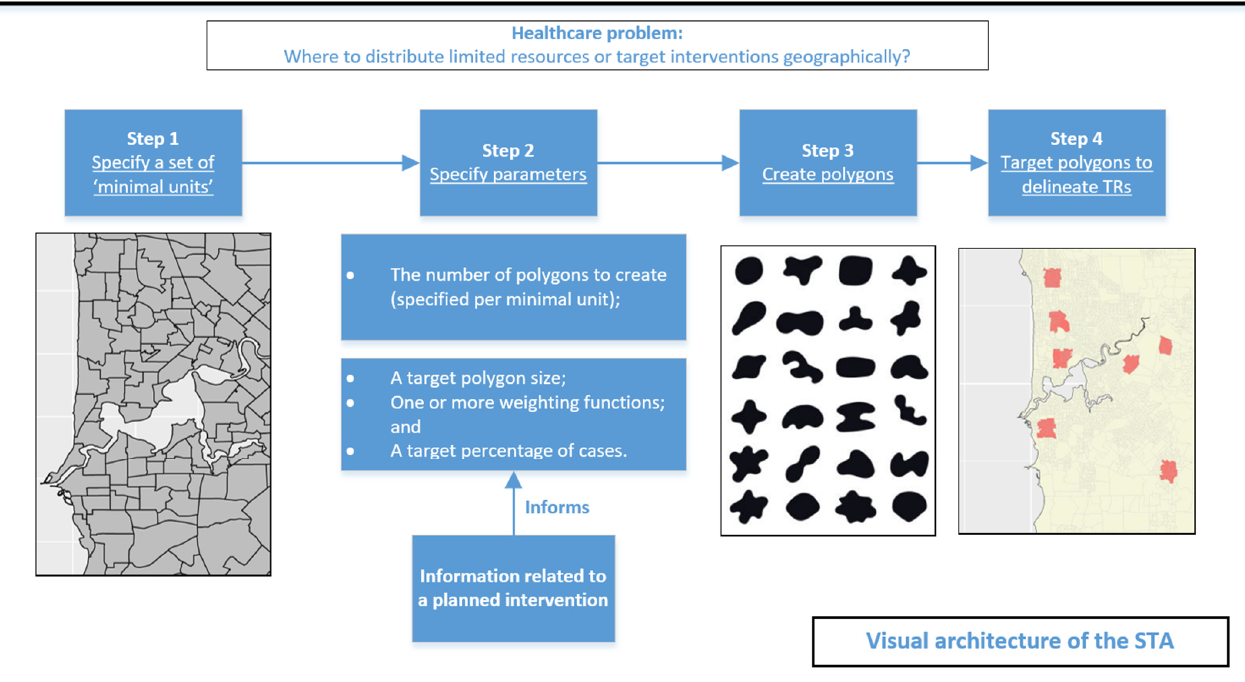
Figure 1. Visual depiction of the architecture of the STA in a healthcare setting.